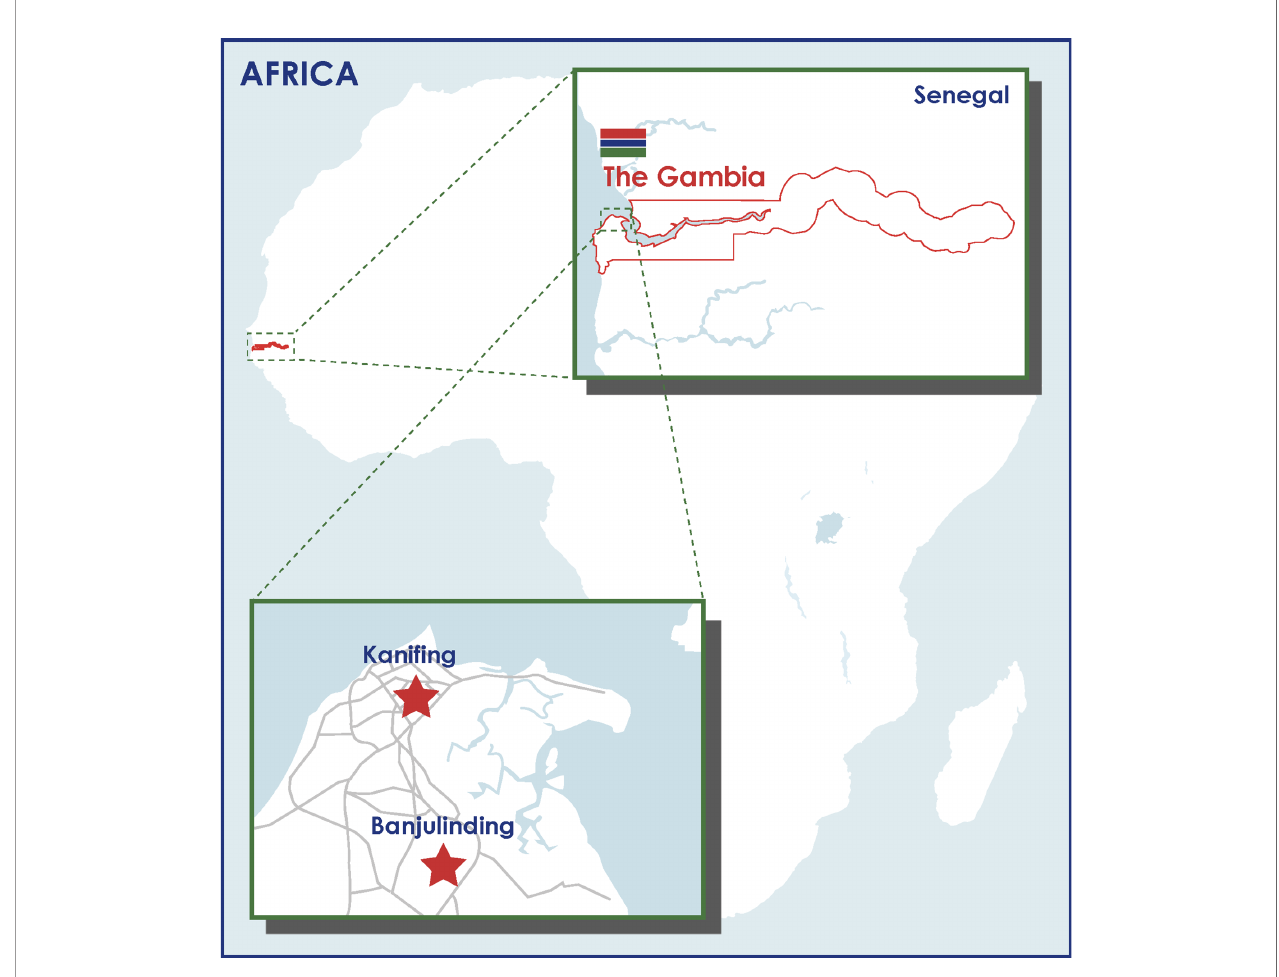
FIGURE 1 | Geographical distribution of the two recruitment sites for the EPIC002 study in The